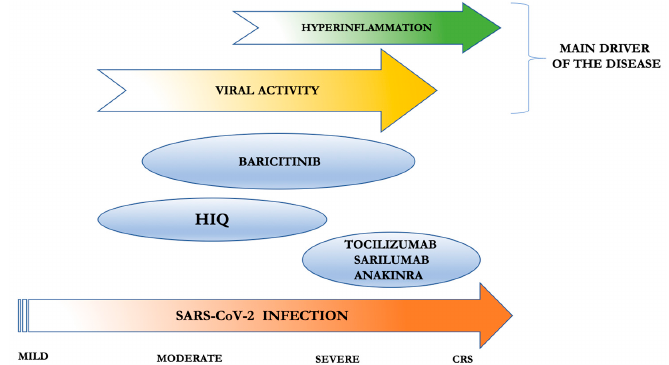
Figure 1. Use of anti-rheumatic immunosuppressive agents in COVID-19 patients, targeted to their immunomodulatory / antiviral activity and disease severity. Tocilizumab, sarilumab, and anakinra have the strongest immunosuppressive effect and have been already tested in cytokine release syndrome (CRS) (with tocilizumab being the only scheduled); thus, they should be administered in severe COVID-19 patients at the first manifestations of hyperinflammation. Baricitinib has both immunosuppressive effects (however, no data are available for CRS) and antiviral activity; thus, it could be adopted in the moderate / severe form of COVID-19. Hydroxychloroquine (HIQ) has antiviral properties and milder immunosuppressive